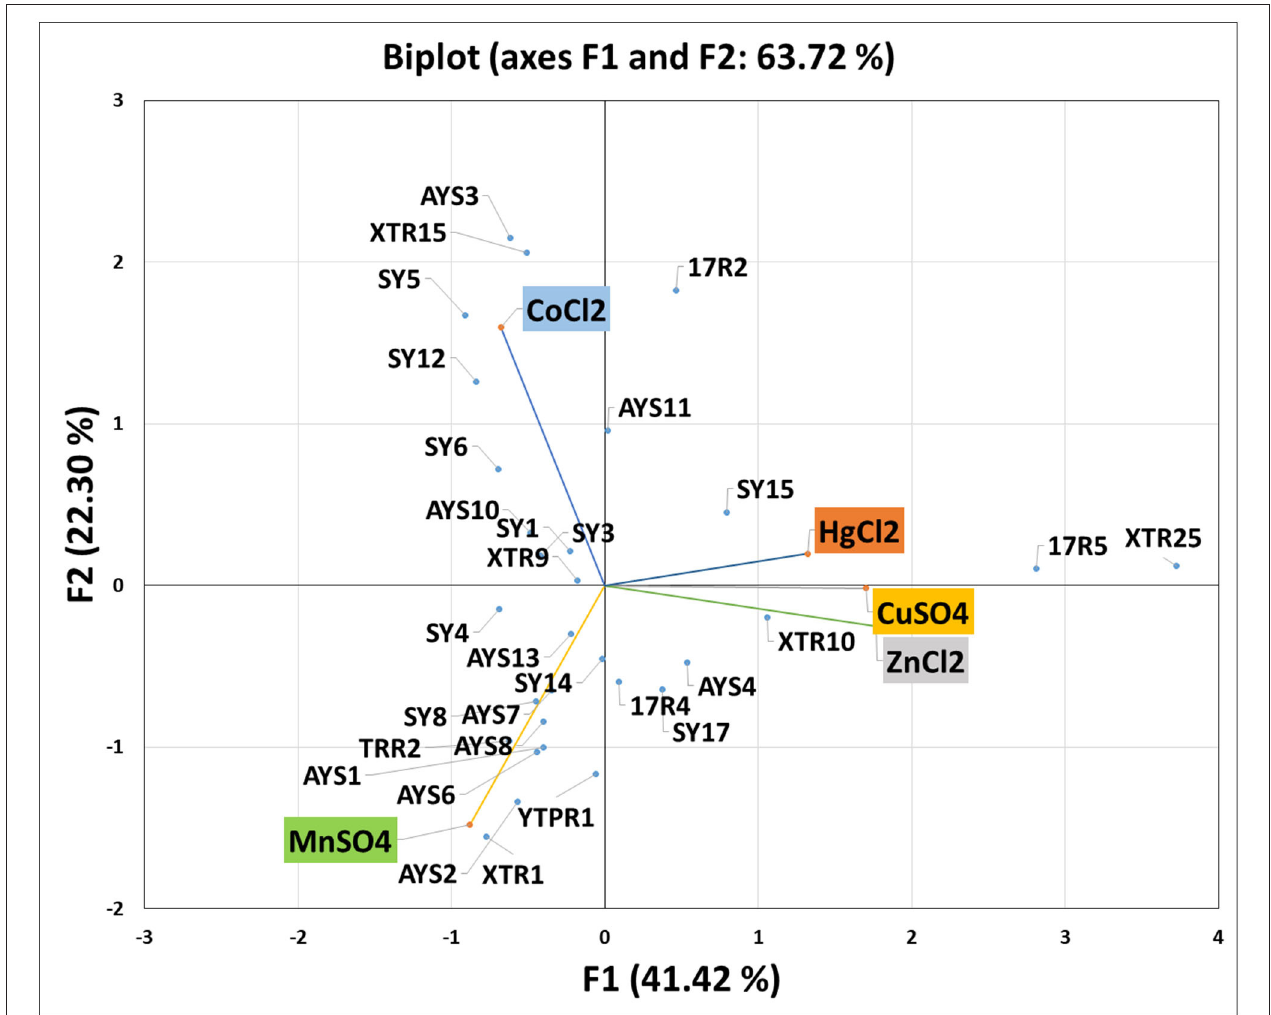
FIGURE 4 | Principal component analysis showing the correlation of heavy metals and isolated